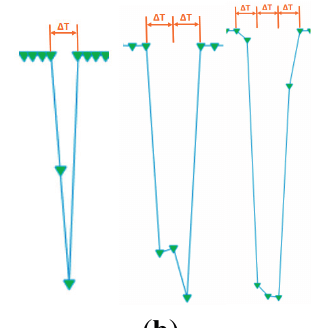
Figure 18. UIS ULT node test. ( a ) Ultrasound detection; ( b ) Detection of different kinds of vehicles through pulse width.